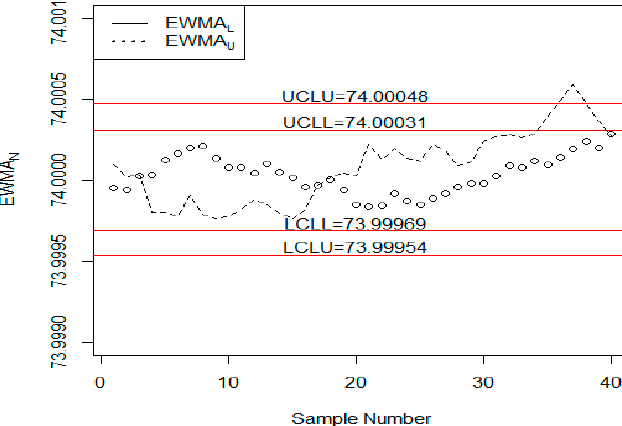
Figure 1. The proposed chart for the summated data.